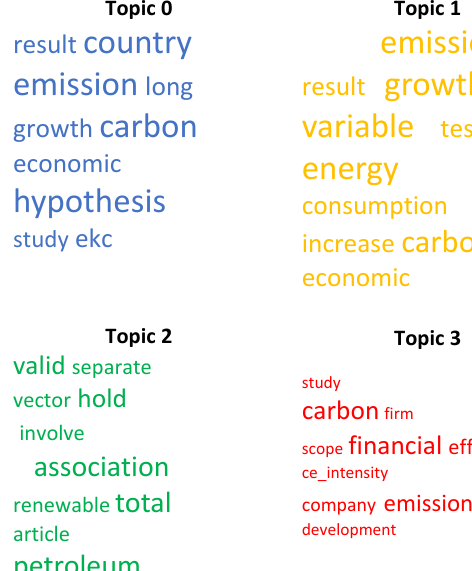
Figure 4. Word clouds of top keywords in each topic